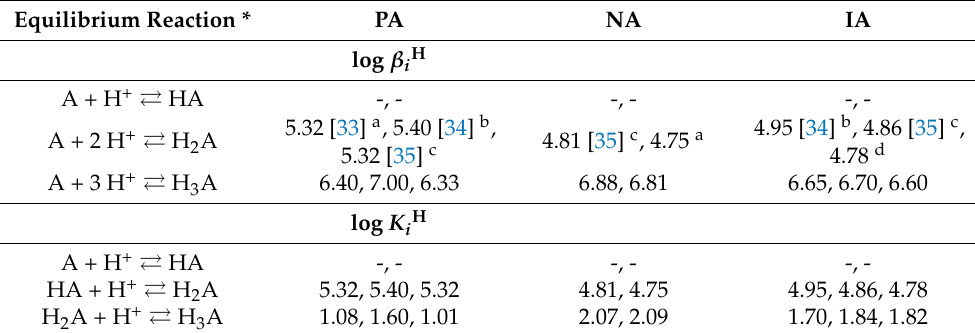
Table 7. Collection of literature overall ( β iH ) and stepwise ( K iH ) protonation constants of PA, NA, and IA in aqueous